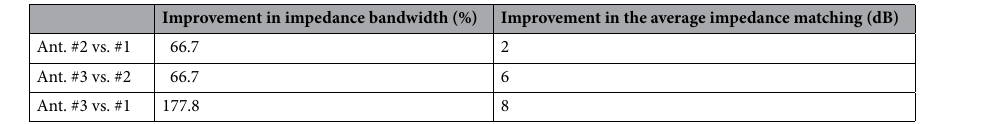
Table 3. Bandwidth & impedance match comparison of the three antennas.